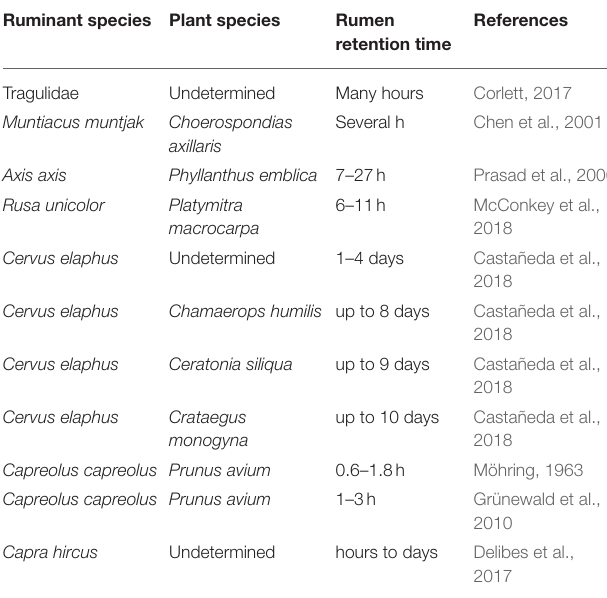
TABLE 4 | Elapsed time between fruit ingestion and seed release from the cud (i.e., seed retention time at the rumen) according different